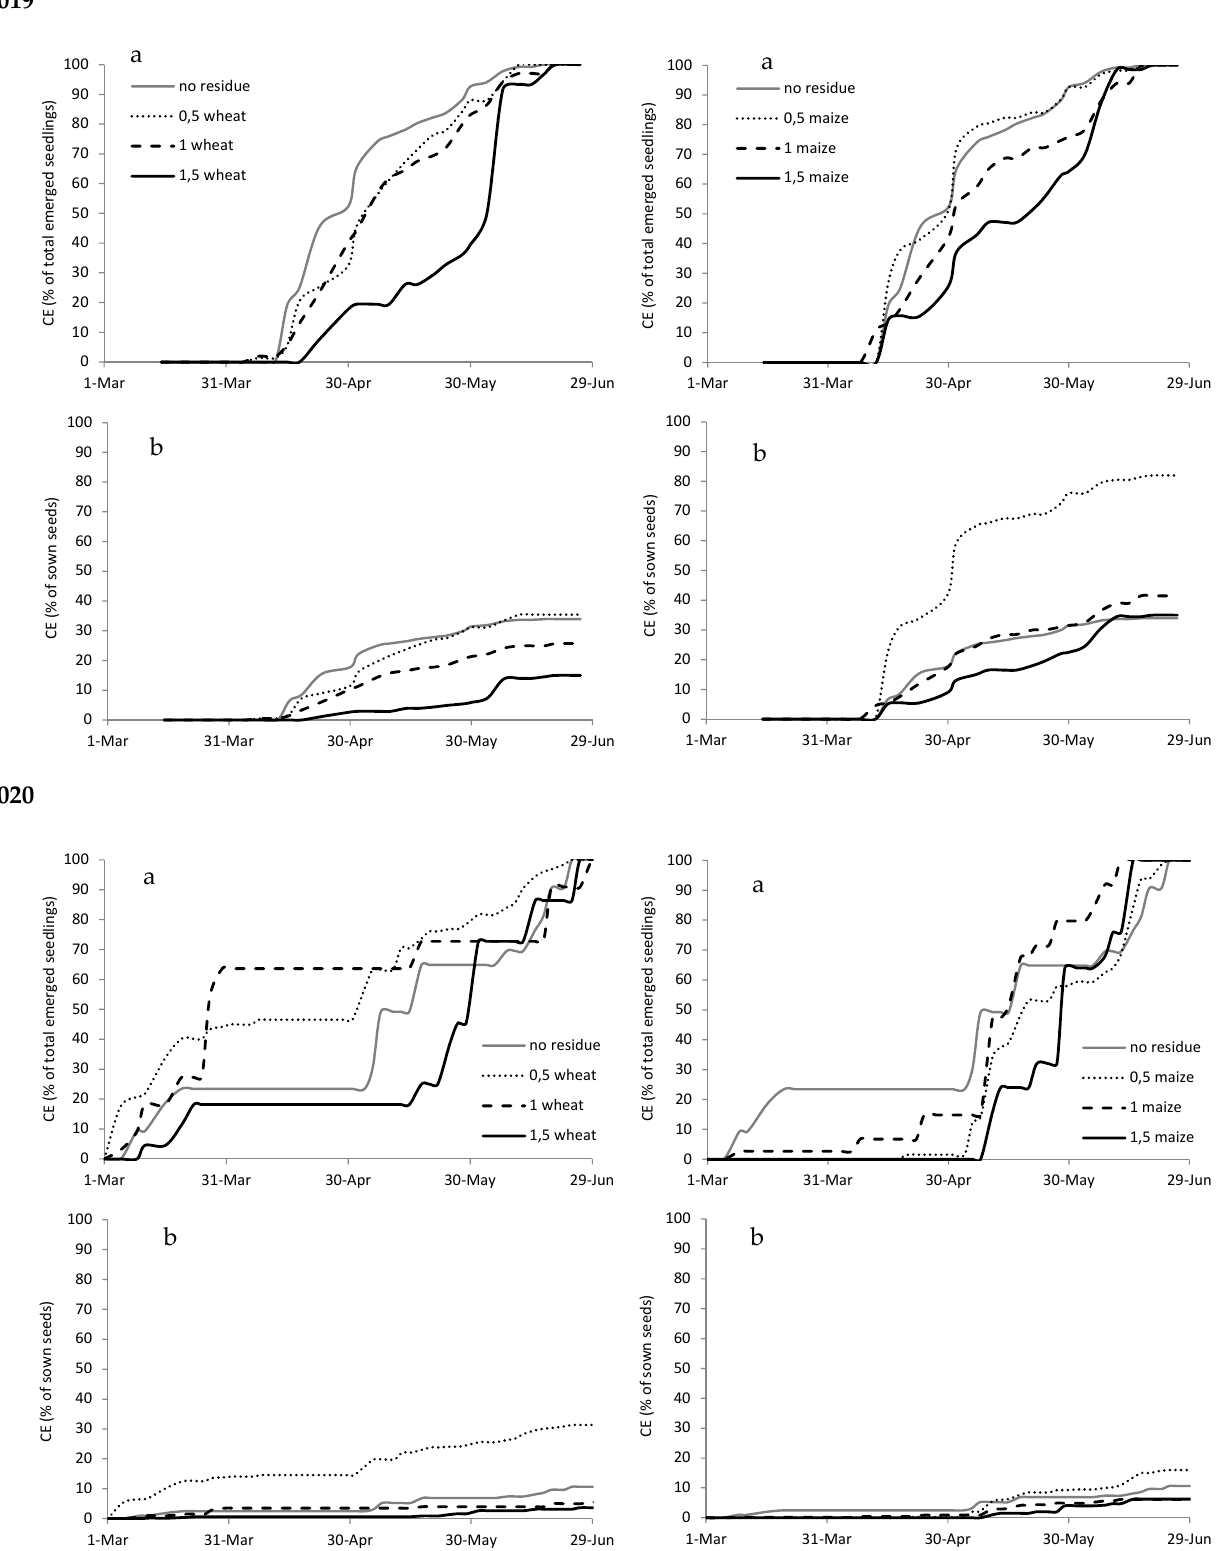
Figure A2. Cumulated emergence (CE) expressed as percentage of total emerged seedlings ( a ) and as percentage of sown seeds ( b ) of Amaranthus retroflexus in 2019 and 2020 with different types (wheat on the left and maize on the right) and amounts of crop